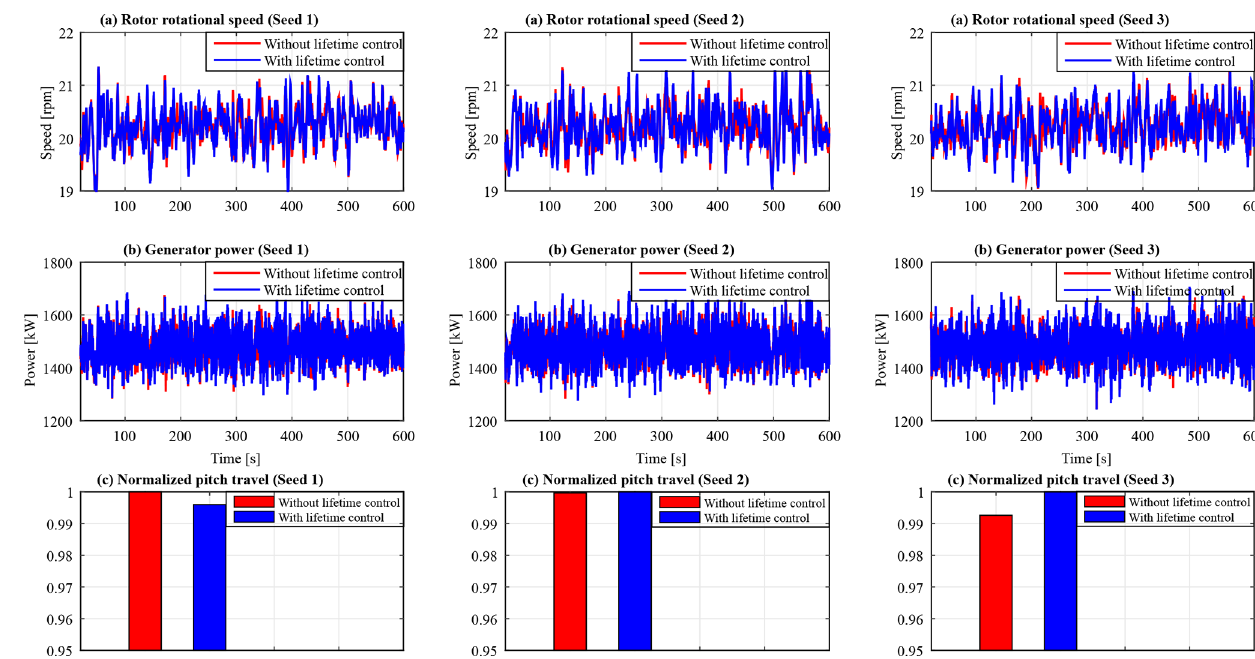
Figure 9. Speed and power regulation performance and pitch actuator usage for 18ms − 1 wind.